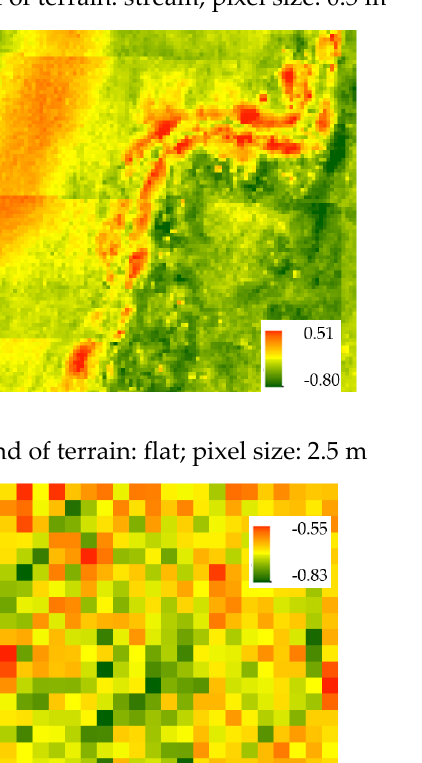
Figure 12. Visualization of the differences.